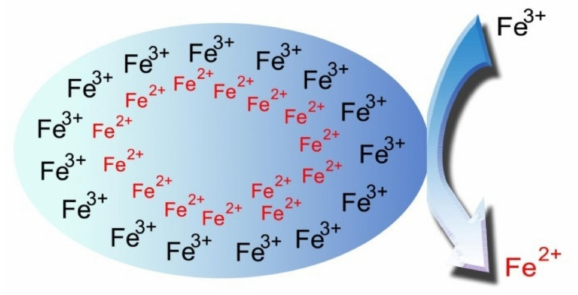
Figure 11. Droplet of ascorbic acid